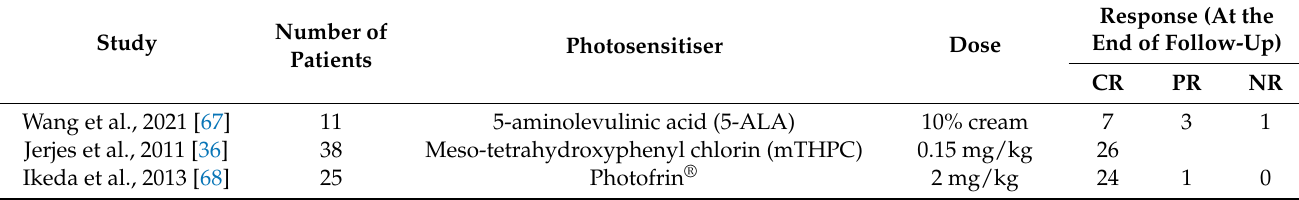
Table 2. Summary of recent clinical trials evaluating the efficacy of PDT in the treatment of oral squamous cell carcinoma. Study